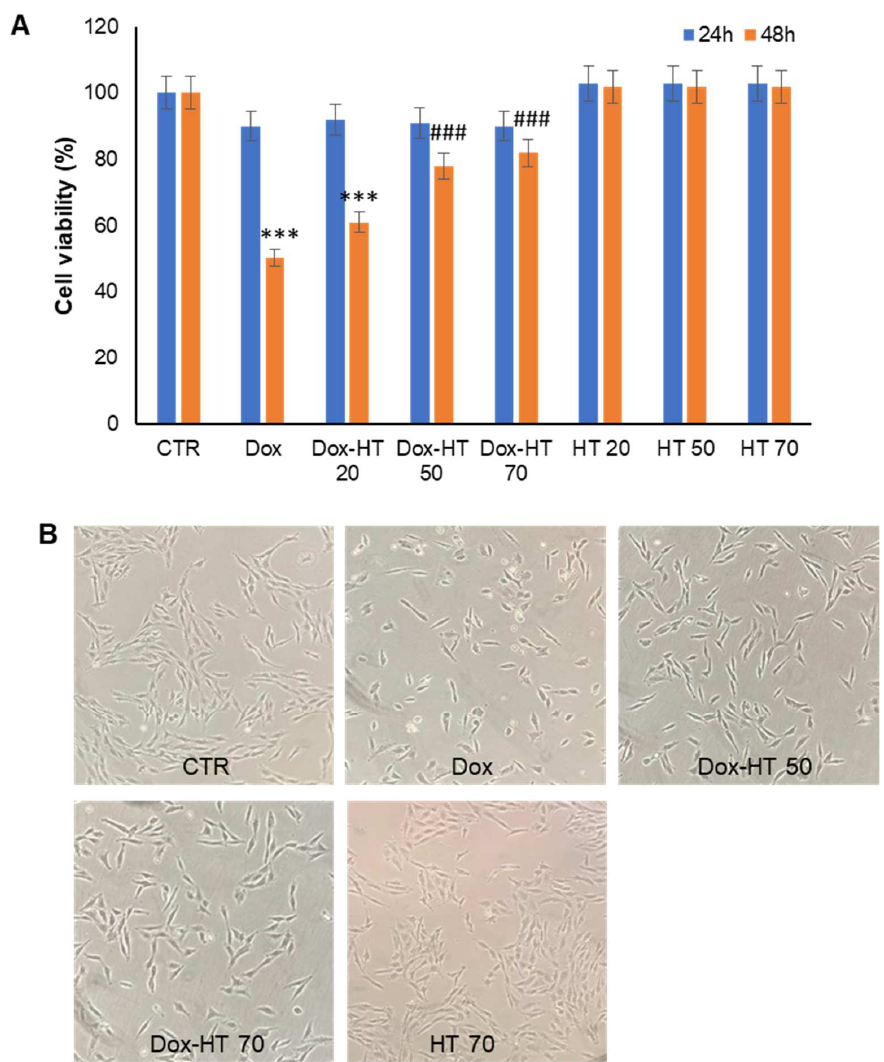
Figure 3. Effect of HT on Dox-induced cytotoxicity. ( A ) Cell viability was evaluated by MTT assay in H9c2 cells exposed to 0.1 μM Dox (Dox), and cotreated with 20 (Dox-HT 20), 50 (Dox-HT 50) and 70 (Dox-HT 70) μM HT for 24 and 48 h. Data are expressed as average percentage of MTT reduction ± SD relative to untreated cells (CTR) from triplicate wells from 5 separate experiments. *** p ˂ 0.001 versus CTR, ### p ˂ 0.001 versus Dox. ( B ) Phase contrast microscopy images (magnification 10×) of H9c2 cells after 48-h incubation. CTR: untreated cells; Dox: cells exposed to 0.1 μM Dox; Dox–HT 50/70: cells cotreated with 50 and 70 μM of HT. Other experimental details are described in the Materials and Methods section.